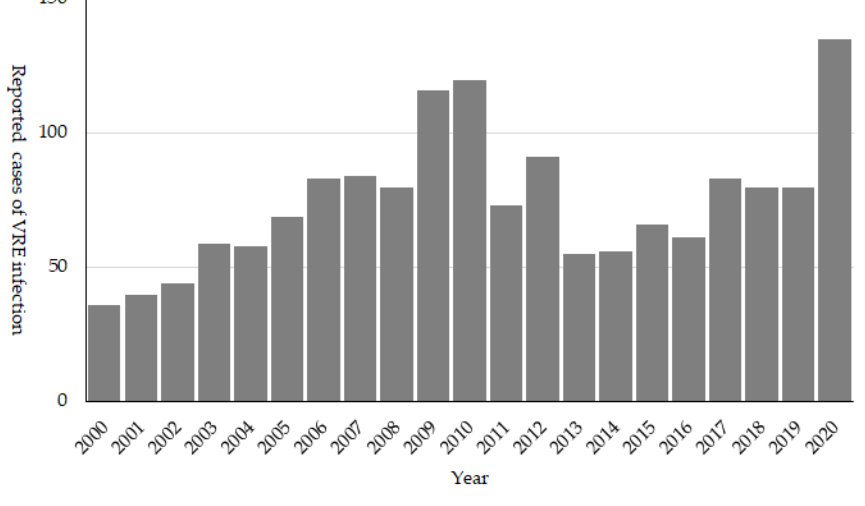
Figure 5. Number of reported cases of VRE infecion, NESID 2011 to 2020.